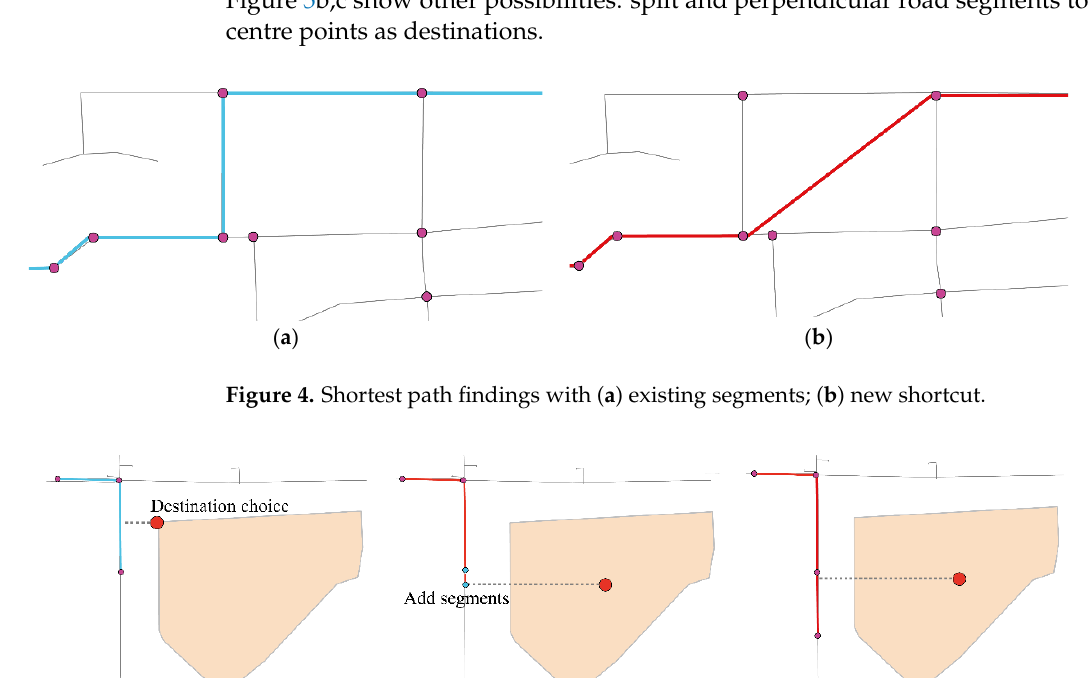
Figure 5b,c show other possibilities: split and perpendicular road segments to find space centre points as destinations.